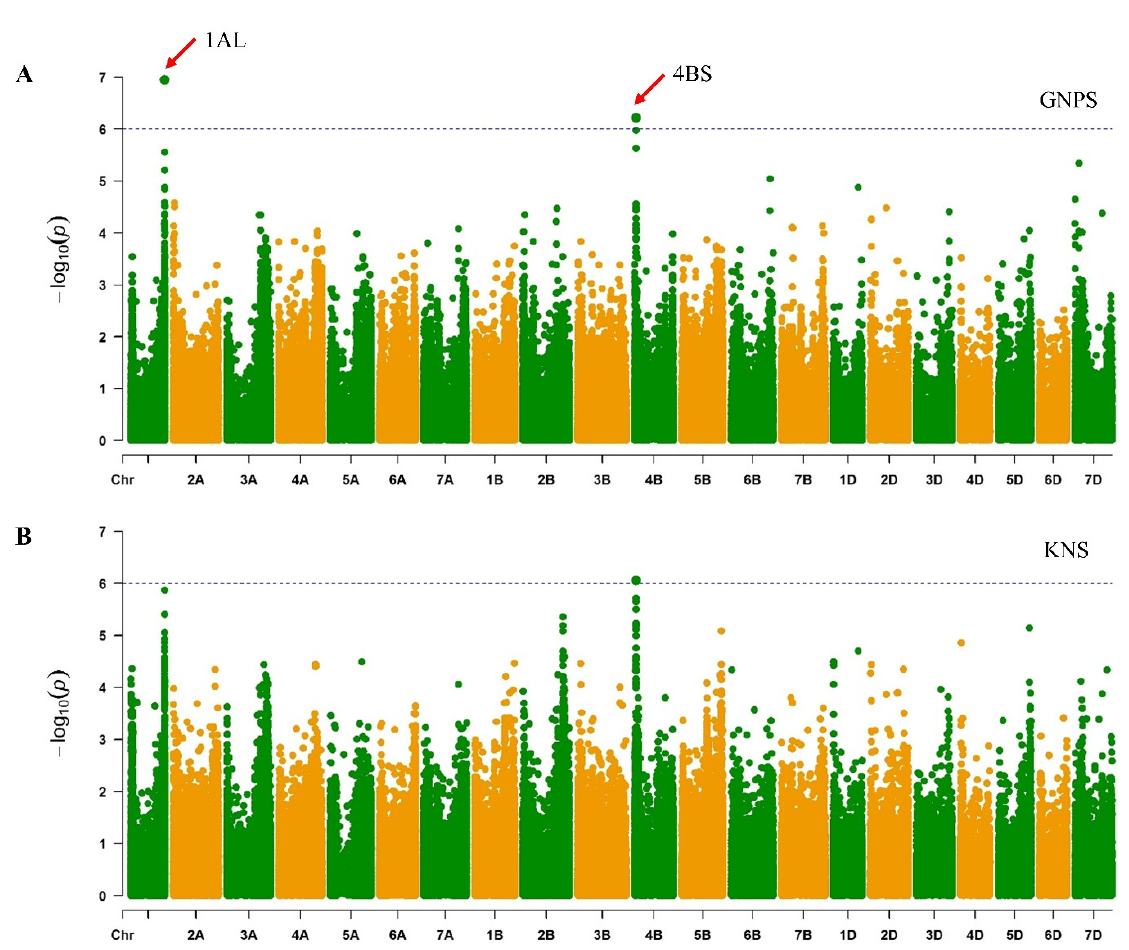
Figure 3. Manhattan plots for spike-related traits including grain number per spike, i.e., GNPS ( A ) and kernel number per spikelet, i.e., KNS ( B ) from the GWAS. The threshold to determine the significant marker-trait associations was set at 1.0 × 10 − 6 . The arrowhead indicates the peak signal containing the candidate pleiotropic genes.